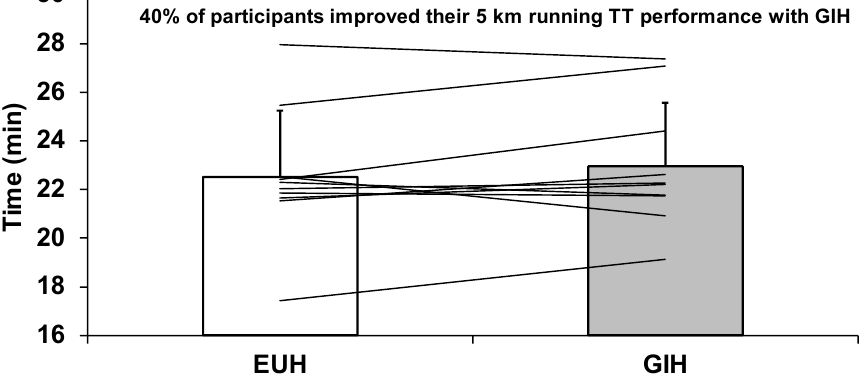
Figure 6. Average and individual performances for the 5 km running time-trial with EUH and GIH. The lines represent changes in individual performances. EUH = euhydrated; GIH = glycerol-induced hyperhydration.